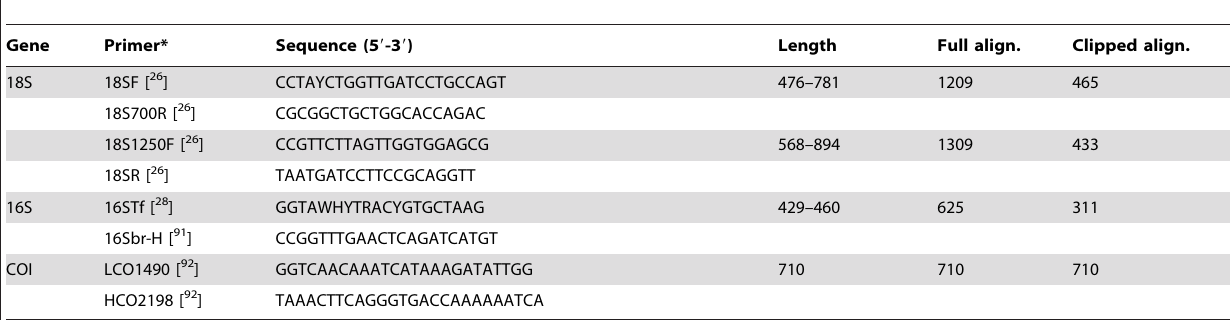
Table 2. Genes sequenced and aligned for phylogenetic analysis.